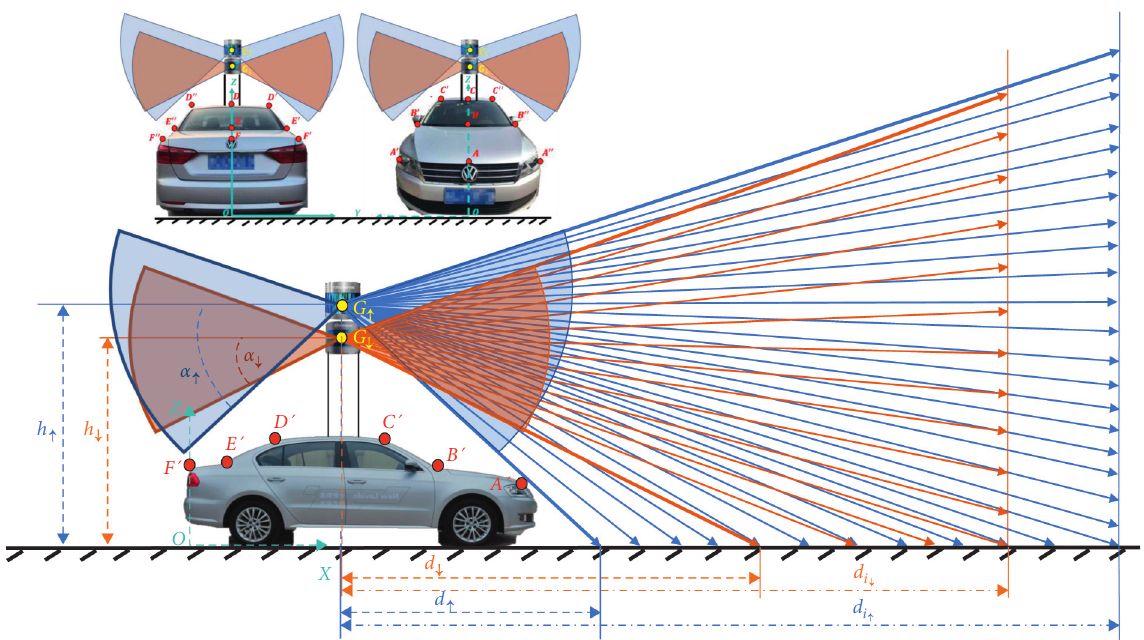
Figure 1: The installation position of the dual multiline LiDAR